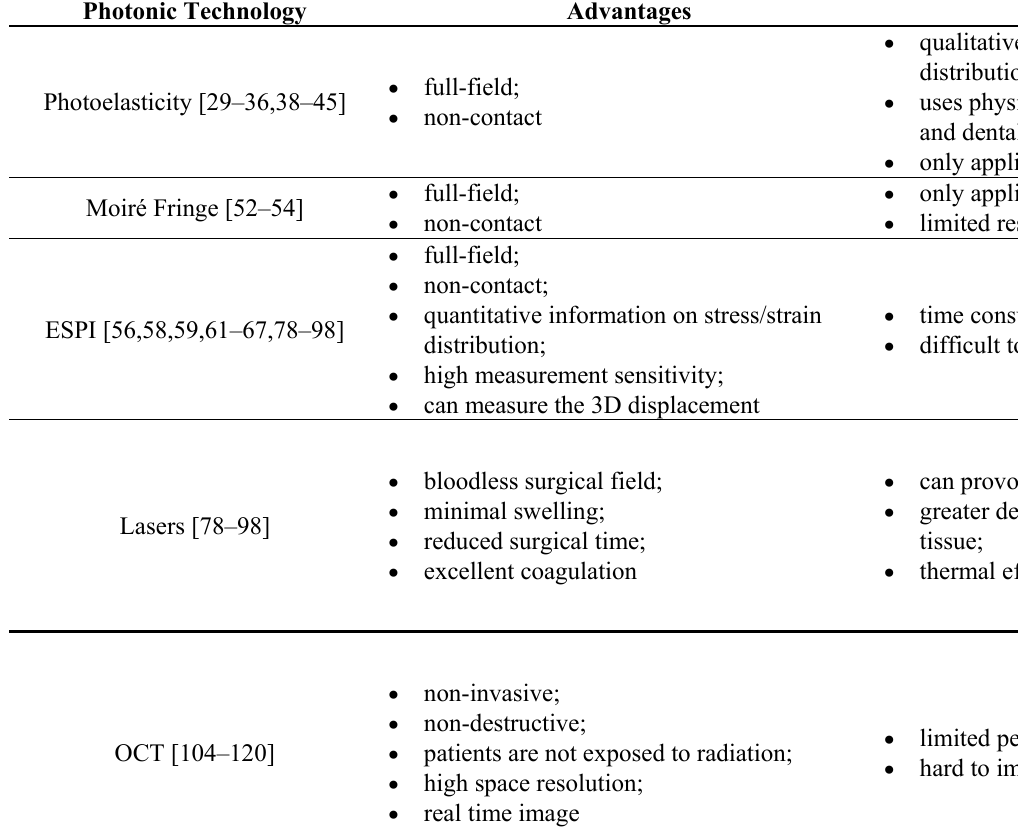
Table 1. Summary of main features of photonic